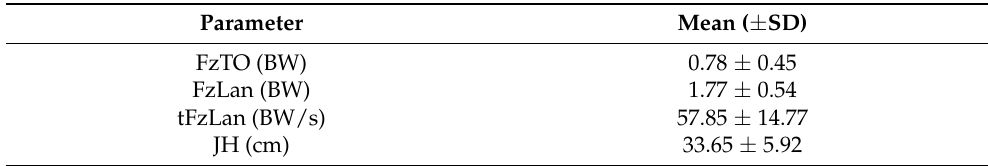
Table 4. Mean nGRF and temporal parameters for CMJs. JH = Jump height; BW = Body weight.